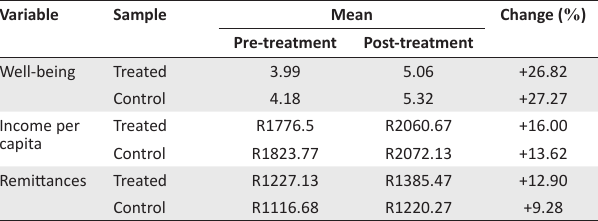
TABLE 1: Comparison of outcome variables across waves (Panel sample). Variable Sample